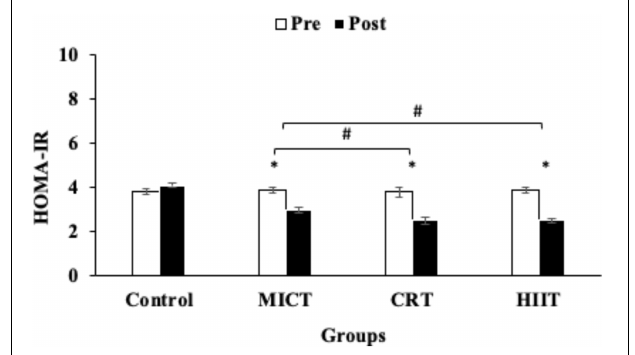
FIGURE 2 | Pre and post training values [mean, sd ( ± )] for Nrg4 (neuregulin 4) in MICT (Moderate Intensity Continuous Training), CRT (Circuit Resistance Training), and HIIT (High Intensity Interval training) groups. *indicates significant differences from the control group ( P < 0.05). # indicates significant differences between training groups ( p < 0.05).